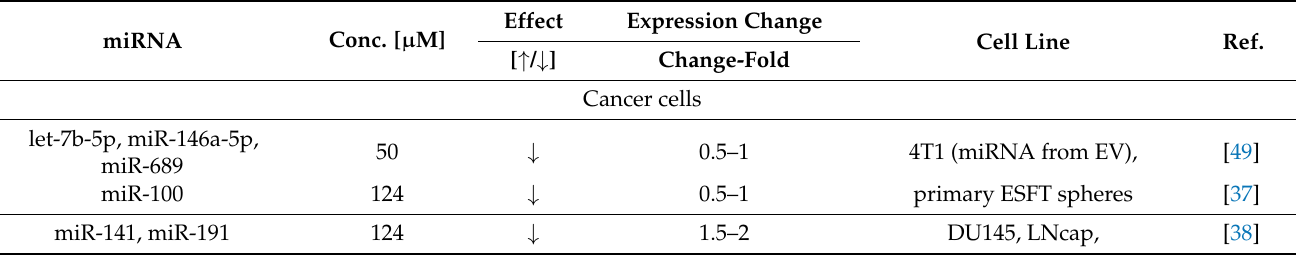
Table 1. The miRNA-regulating activity levels in in vitro studies depending on the different enoxacin